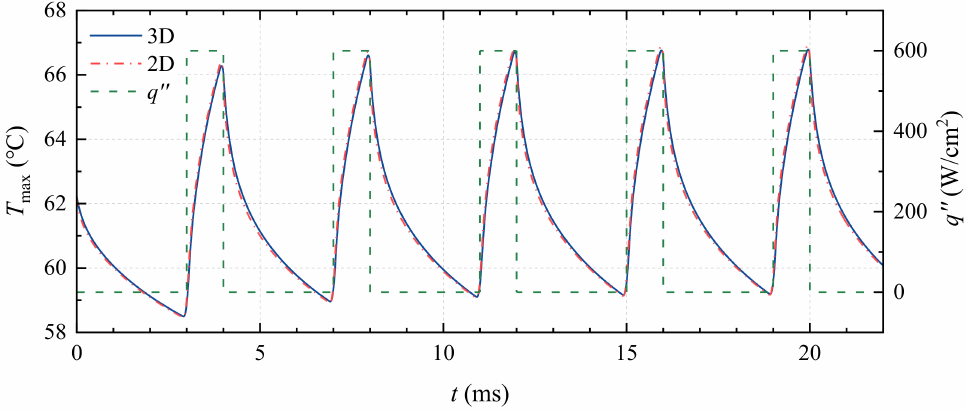
Figure 8. The variations in T max under heat pulses without